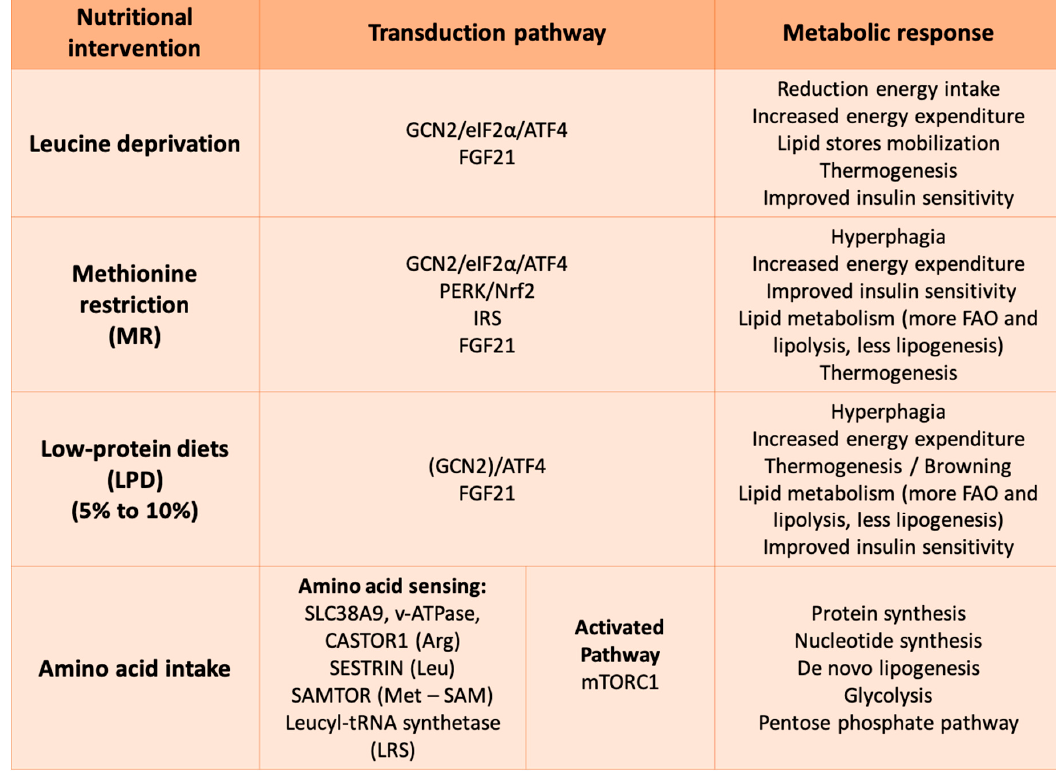
impact on metabolic homeostasis and directly affect not just protein metabolism but also lipid and glucose